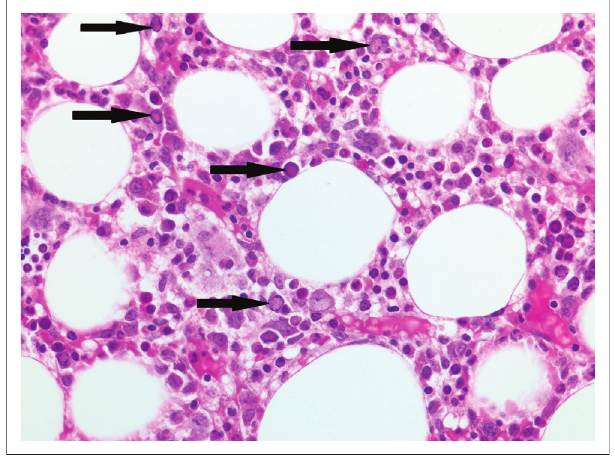
FIGURE 8: Fallopian tube with products of conception and an incidental finding of schistosomal ova (arrow) (original magnification × 100) and inset (original magnification ×